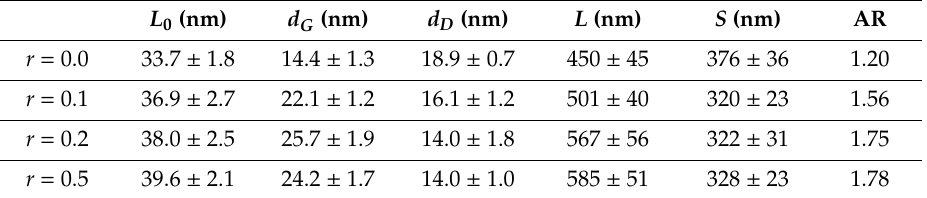
Figure 2. SEM and TEM images of ( a , b ) as-prepared PS 34k - b -PB 25k particles, and after modification with MPA with ( c , d ) r = 0.1, ( e , f ) r = 0.2, ( g , h ) r = 0.5. PB domains were stained with OsO 4 before TEM imaging. Table 1. The summary of average values of domain spacing ( L 0 ), domain thickness, major axis ( L ), minor axis ( S ), and AR ( = L / S ) for pristine PS 34k - b -PB 25k particles and MPA-modified